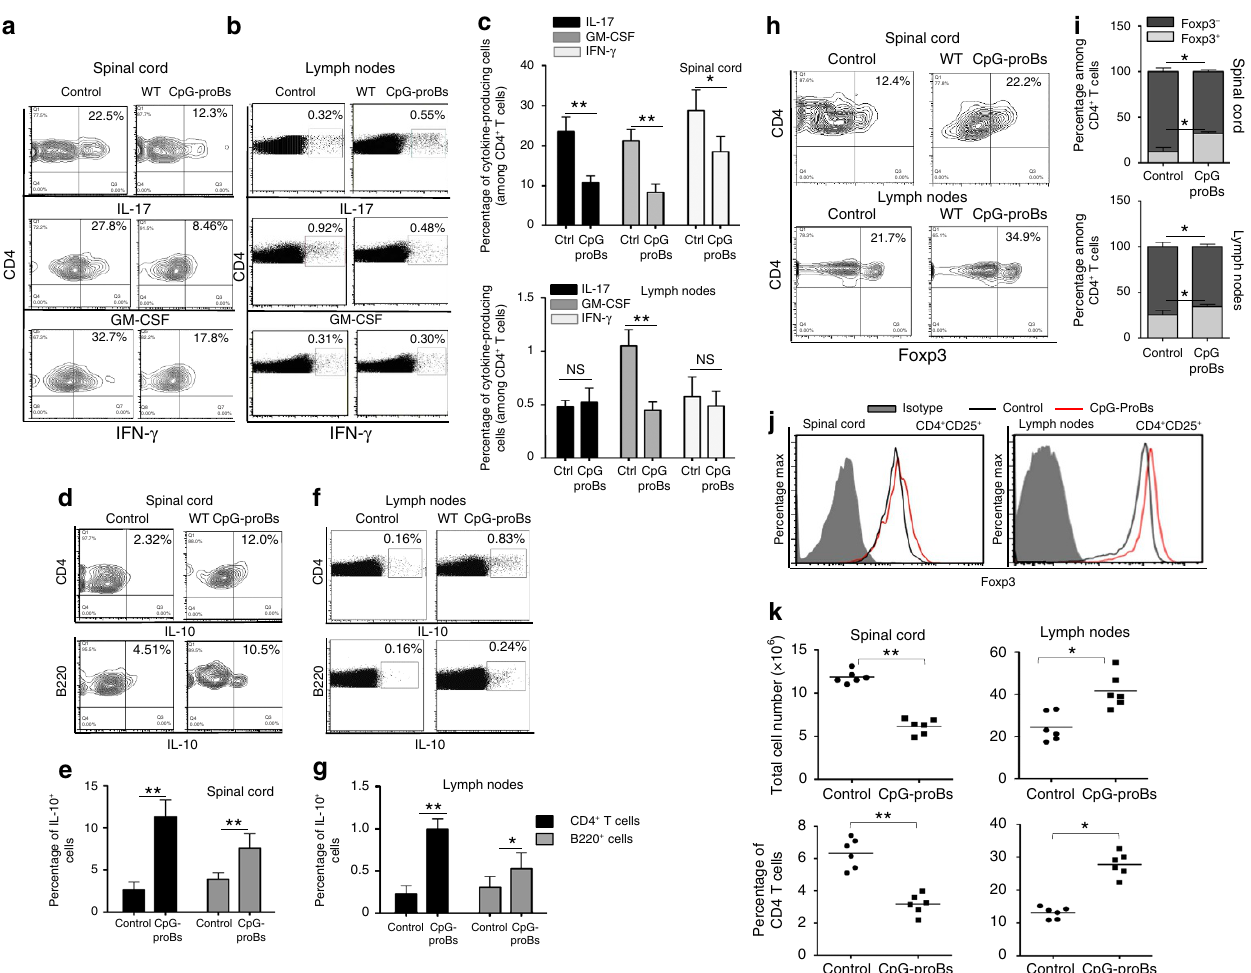
Figure 2 | Protective effects of CpG-proBs at the peak of disease. ( a – c ) Frequency at day 21 of disease of CD4 þ cells producing IL-17, GM-CSF, IFN- g in spinal cord in a representative experiment ( a ) and in four experiments ( c ), and in reactive (cervical, axillary and inguinal) LN ( b , c ) prepared as described in the ‘Methods’ section. ( d – g ) Production of IL-10 by CD4 þ T cells and B220 þ B cells from spinal cord ( d , e ) or reactive LN ( f , g ) of control or CpG-proB-recipient mice in a representative experiment ( d , f ) and in three experiments ( e , g ) in which values are expressed as mean ± s.e.m. ( h ) Frequency within gated CD4 þ cells of cells with nuclear expression of the transcription factor Foxp3 in spinal cord and reactive LN. ( i , j ) Percentages